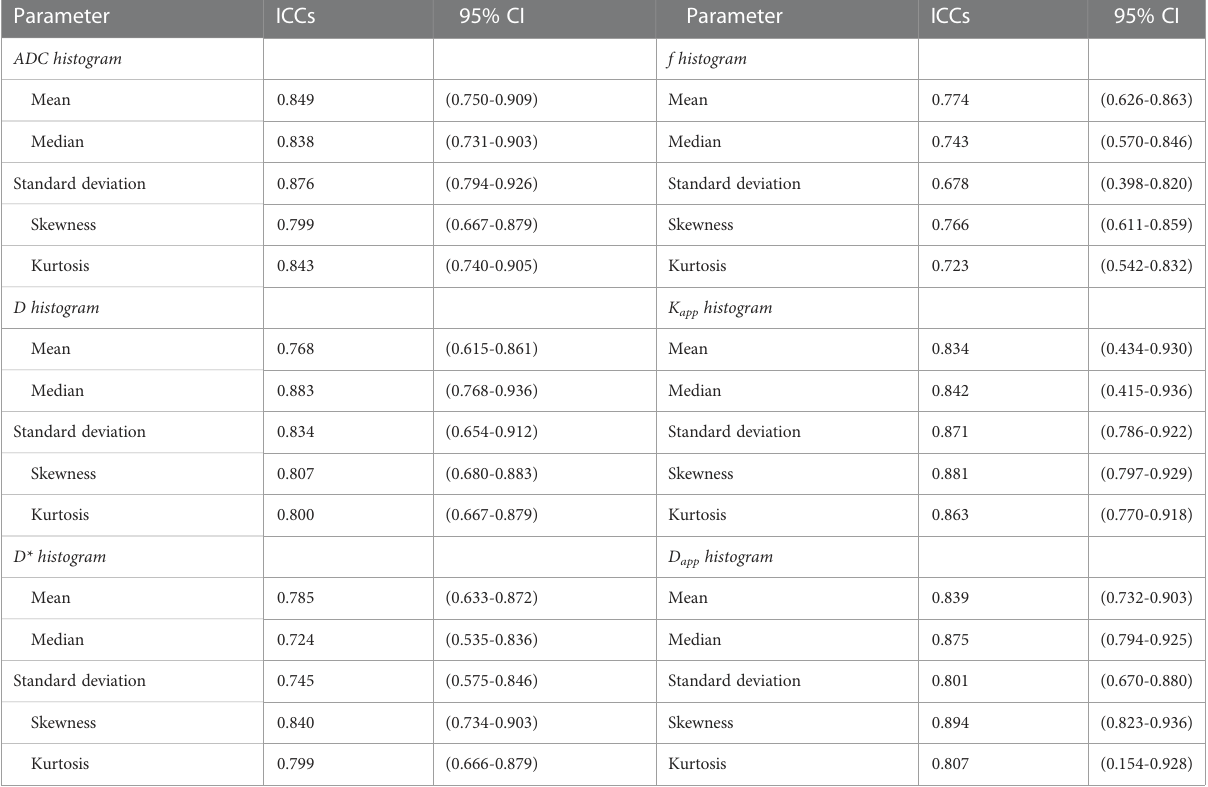
TABLE 3 Intra-observer agreement on whole-volume histogram parameters.